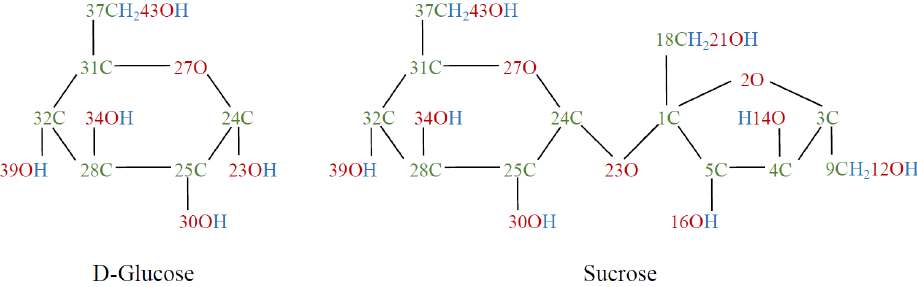
Figure 1. Sugar molecules of D-glucose ( left ) and sucrose ( right ) in Haworth